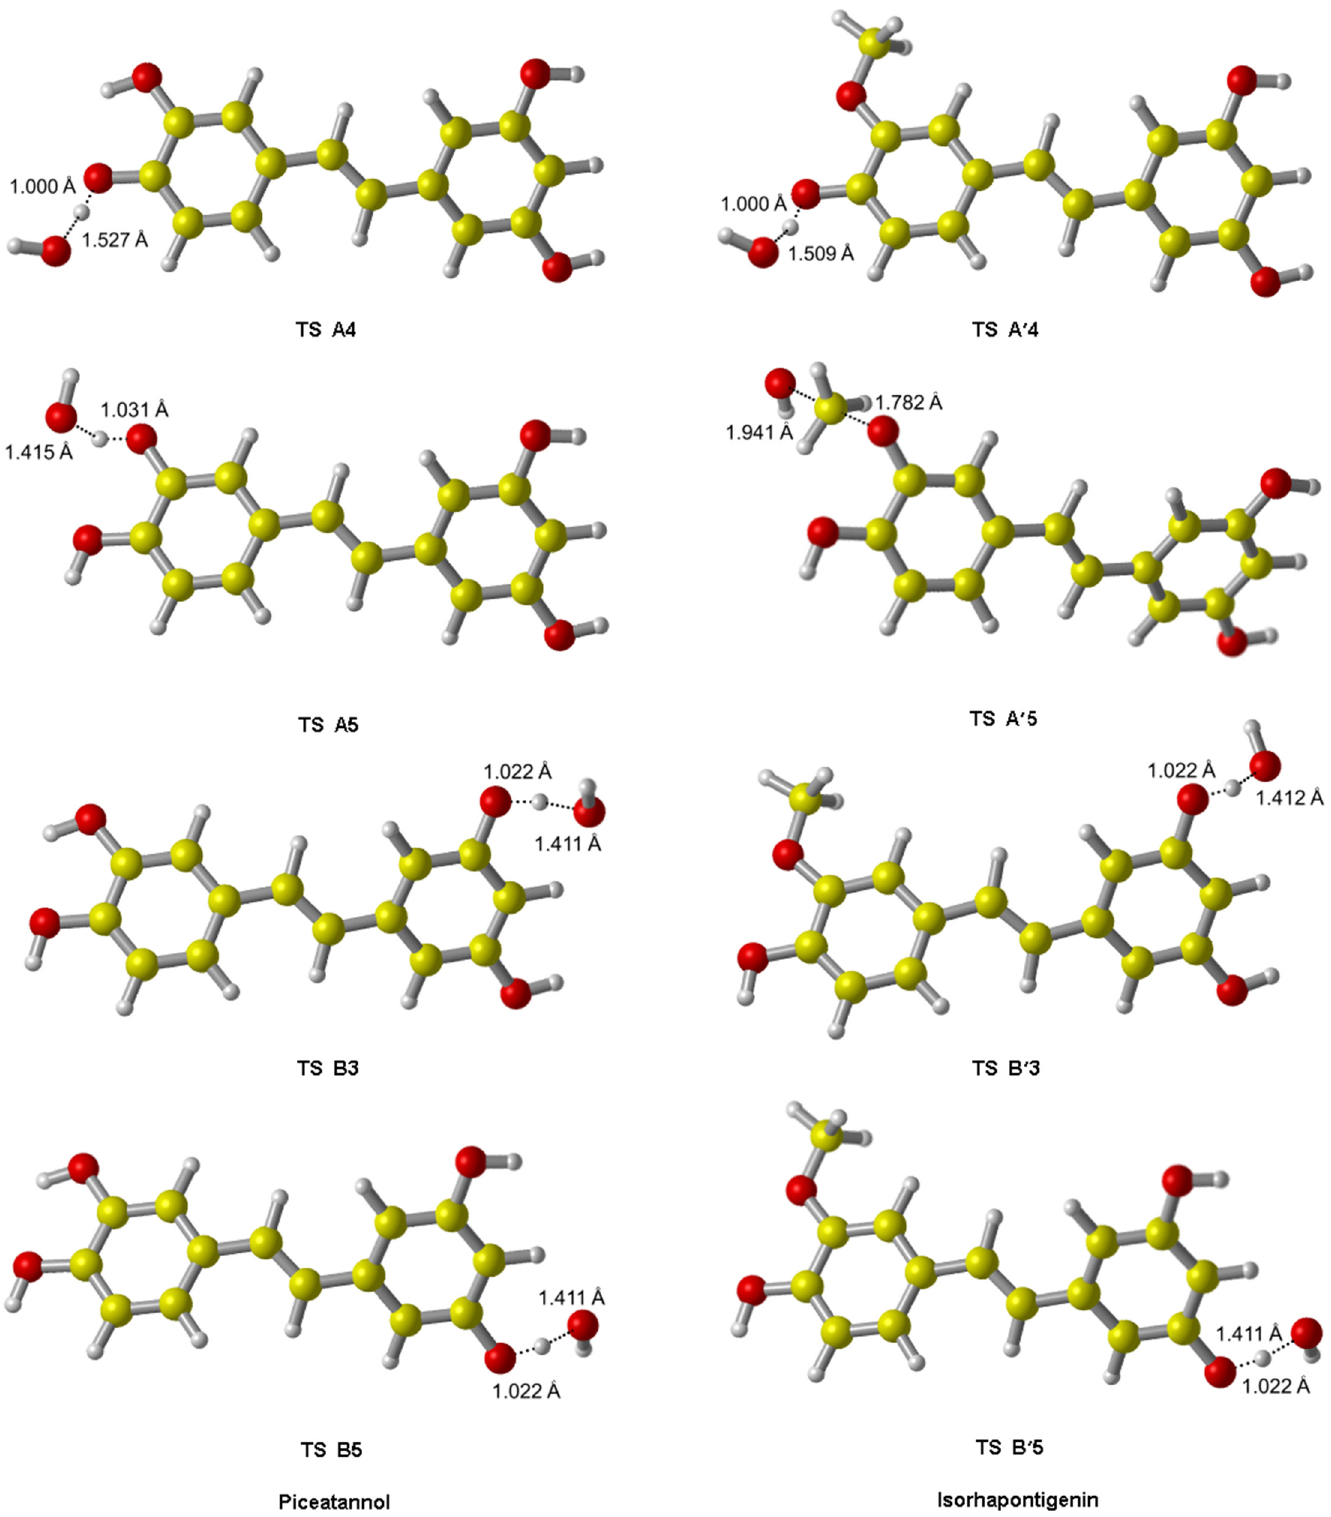
Fig 3. The transition state geometries of PIC and ISO from ABS reactions initiated by (cid:129) OH. The elongations of the breaking bonds are smaller than those of the forming bonds, indicating these TS are all reactant-like, i.e. these reactions are all exothermic in light of the Hammond ’ s postulate. These agree with our calculated results in Table